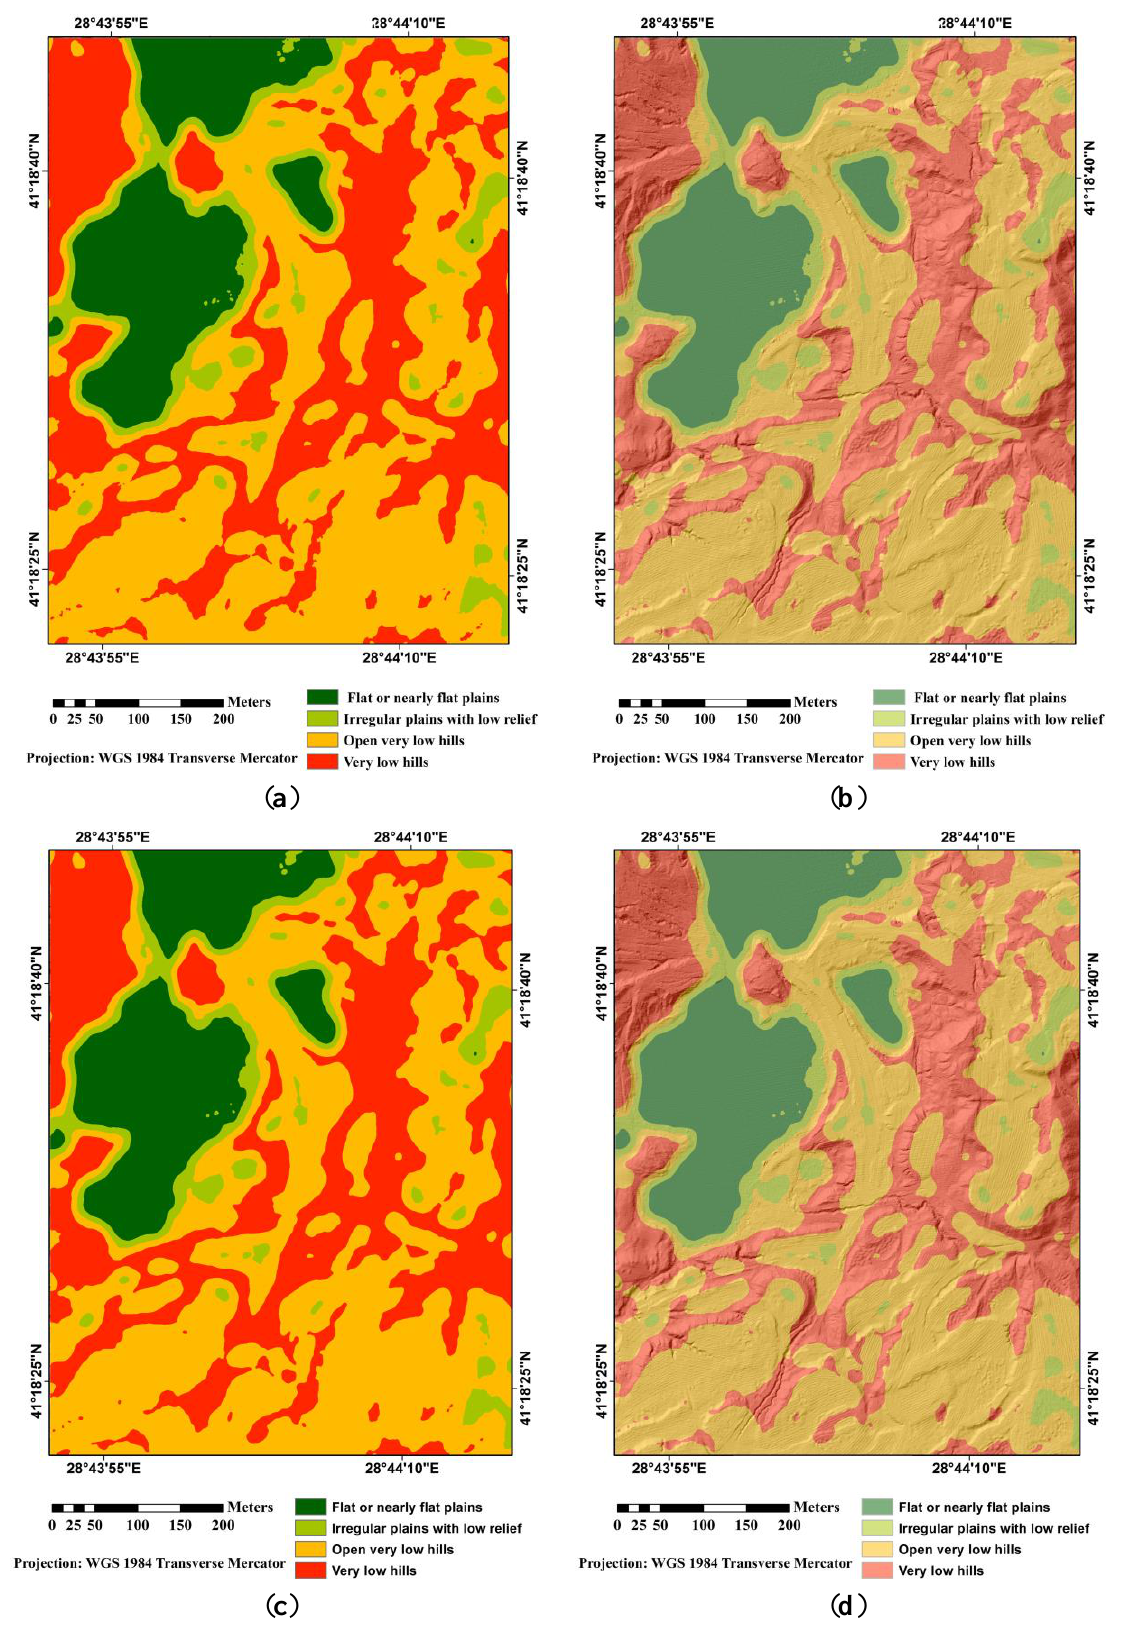
Figure 5. ( a ) Generalized landform map at 1:1000; ( b ) Hillshaded generalized landform map at 1:1000; ( c ) Generalized landform map at 1:5000; ( d ) Hillshaded generalized landform map at